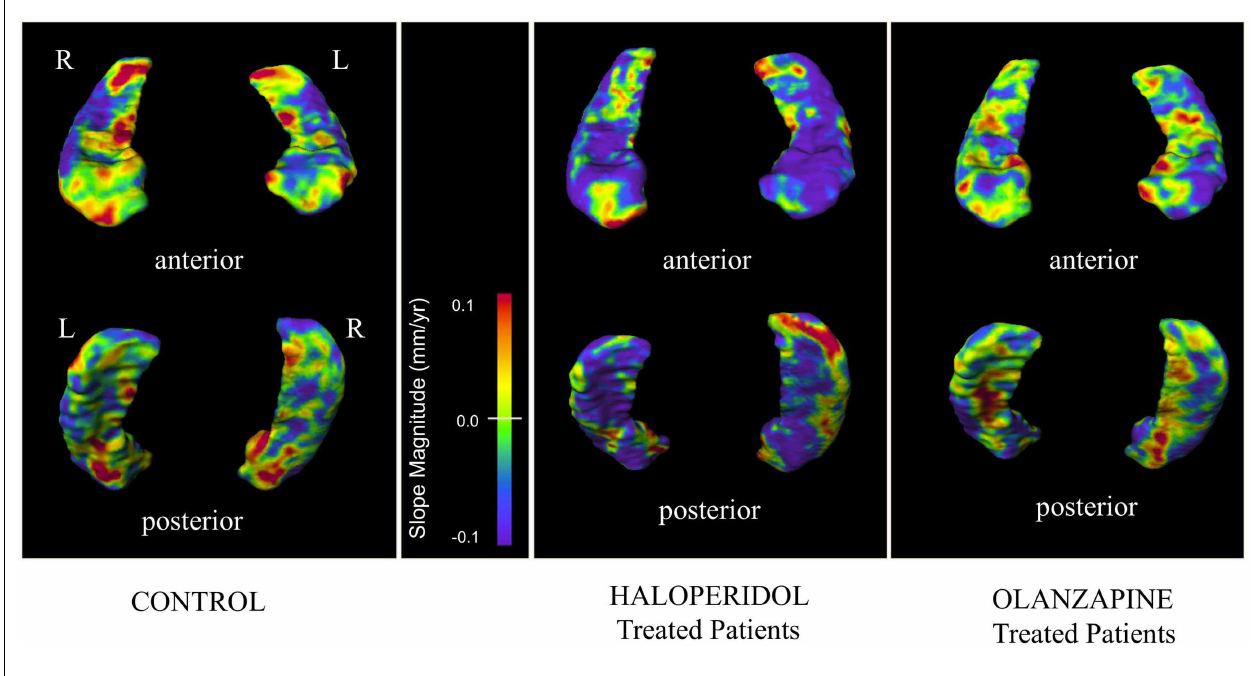
are color-coded, with purple/blue regions denoting regions of longitudinal surface contraction and red/orange regions denoting regions of longitudinal surface expansion. Surface maps are thresholded between slope values of ±